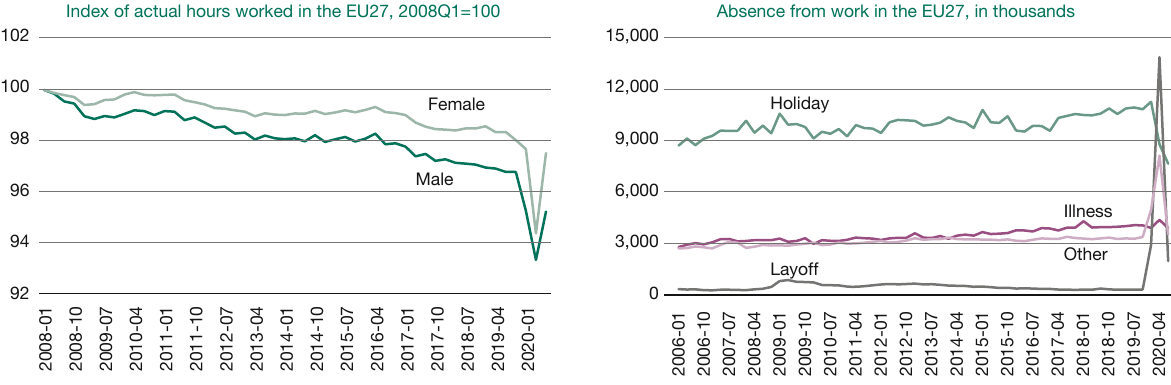
Figure 1 The impact of the COVID-19 pandemic on employment in the EU